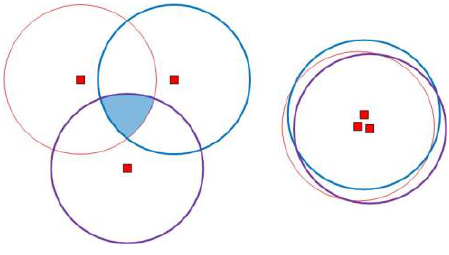
Figure 7. Anchor node coverage analysis.